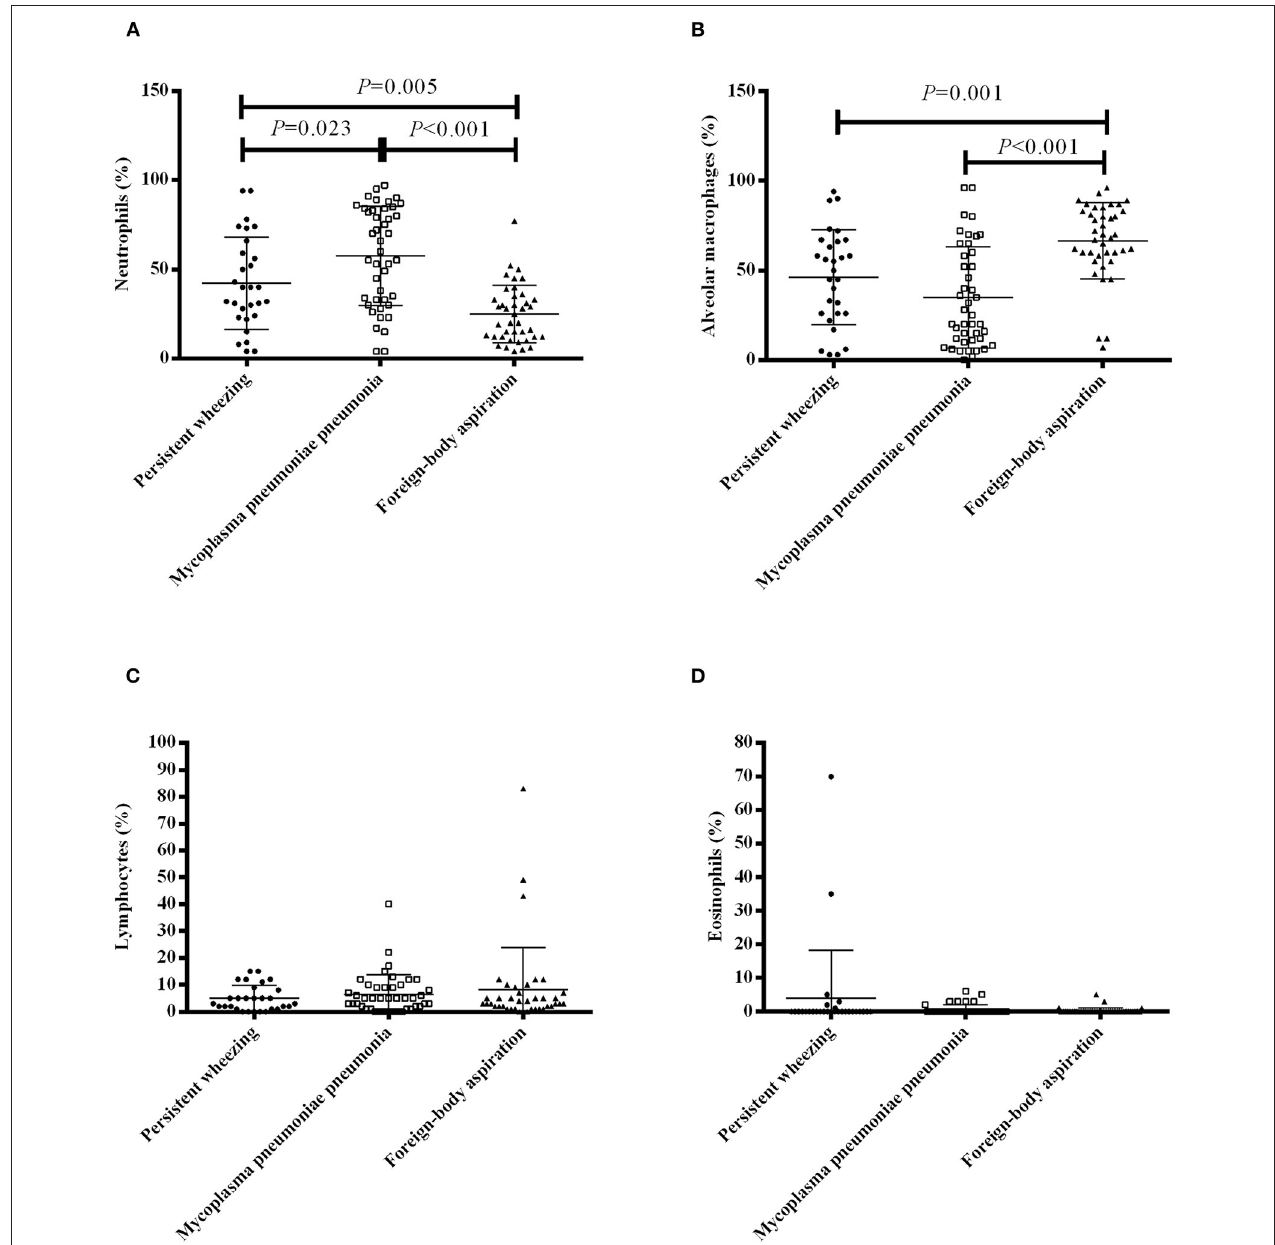
FIGURE 1 | BALF cell profile in patients with PW, MPP and FBA. The percentages of neutrophils (A) , alveolar macrophages (B) , lymphocytes (C) and eosinophils (D) in bronchoalveolar lavage of patients with PW, MPP and FBA. Each dot, box and triangle indicates an individual patient.